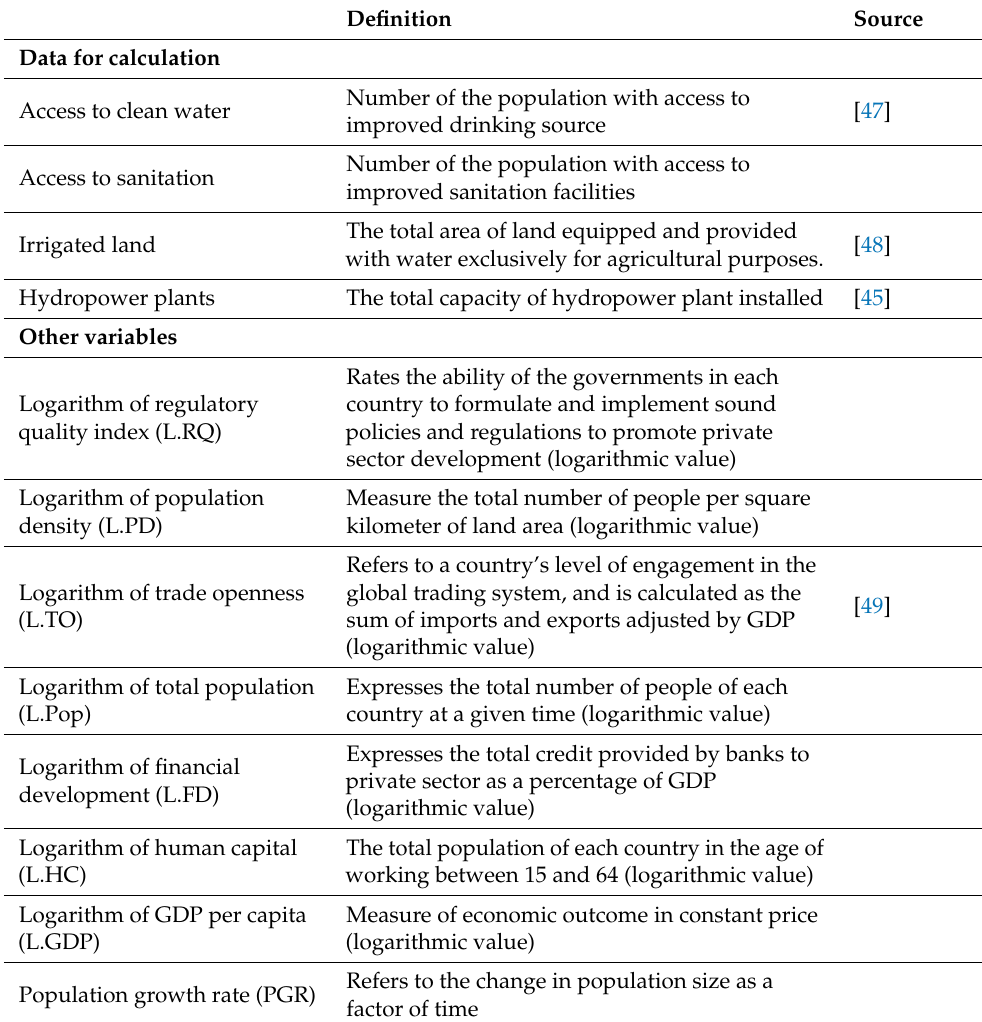
Table 1. Variables definition and sources.